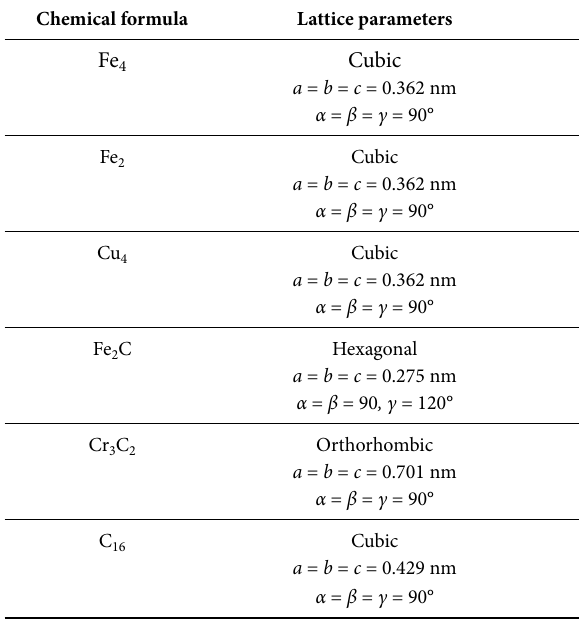
Table 6. Lattice parameters of workpiece surface phases, work- piece-24.